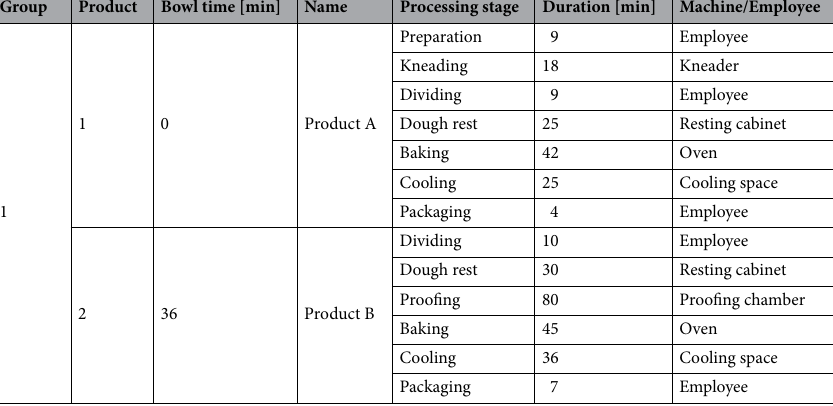
Table 1. Simplified production data for one product